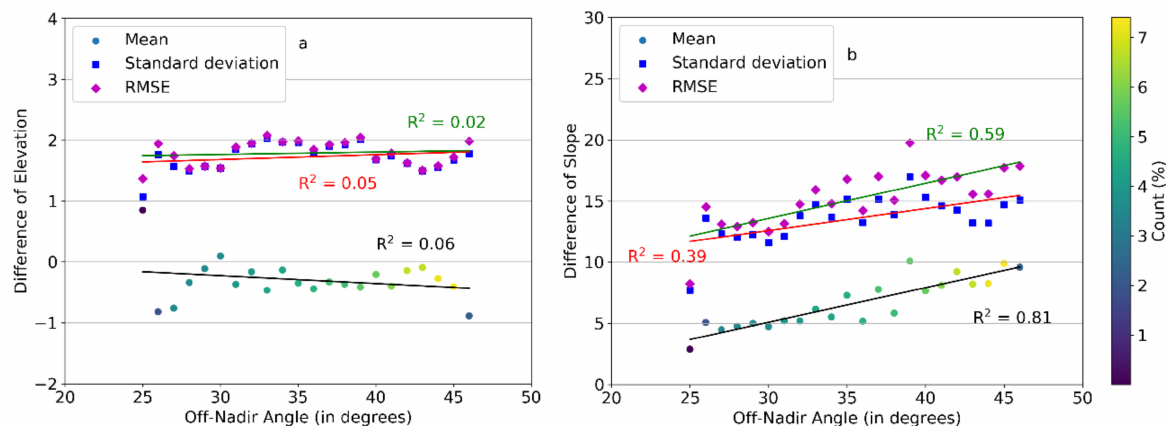
Figure 9. Relation between off-nadir angle and difference of elevation ( a ) and difference of slope ( b ). The mean value is represented using dots, whose color indicates the percentage of DTM points used to calculate the mean and standard deviation (see color bar on the right side). The lines represent the regression lines for the mean, the standard deviation and the